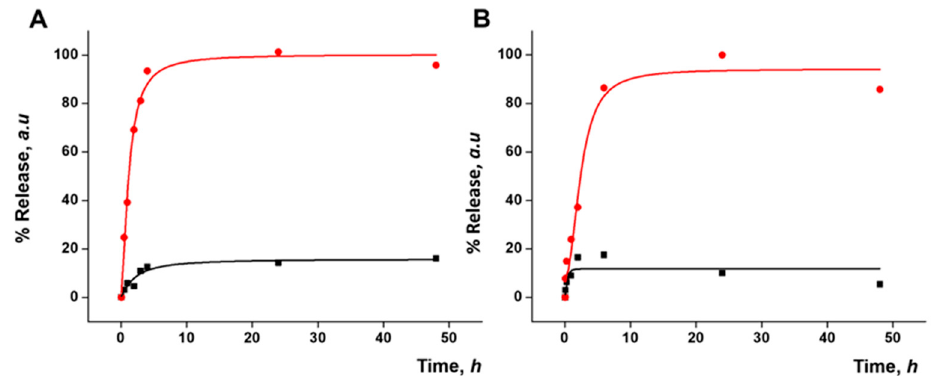
Figure 6. Kinetic release profile of safranin O delivered from HA gel containing 6 mg · mL − 1 of S2 ( A ) or of DOX delivered from HA gel containing 6 mg · mL − 1 of S3 ( B ) in the absence (black) and in the presence (red) of GSH.